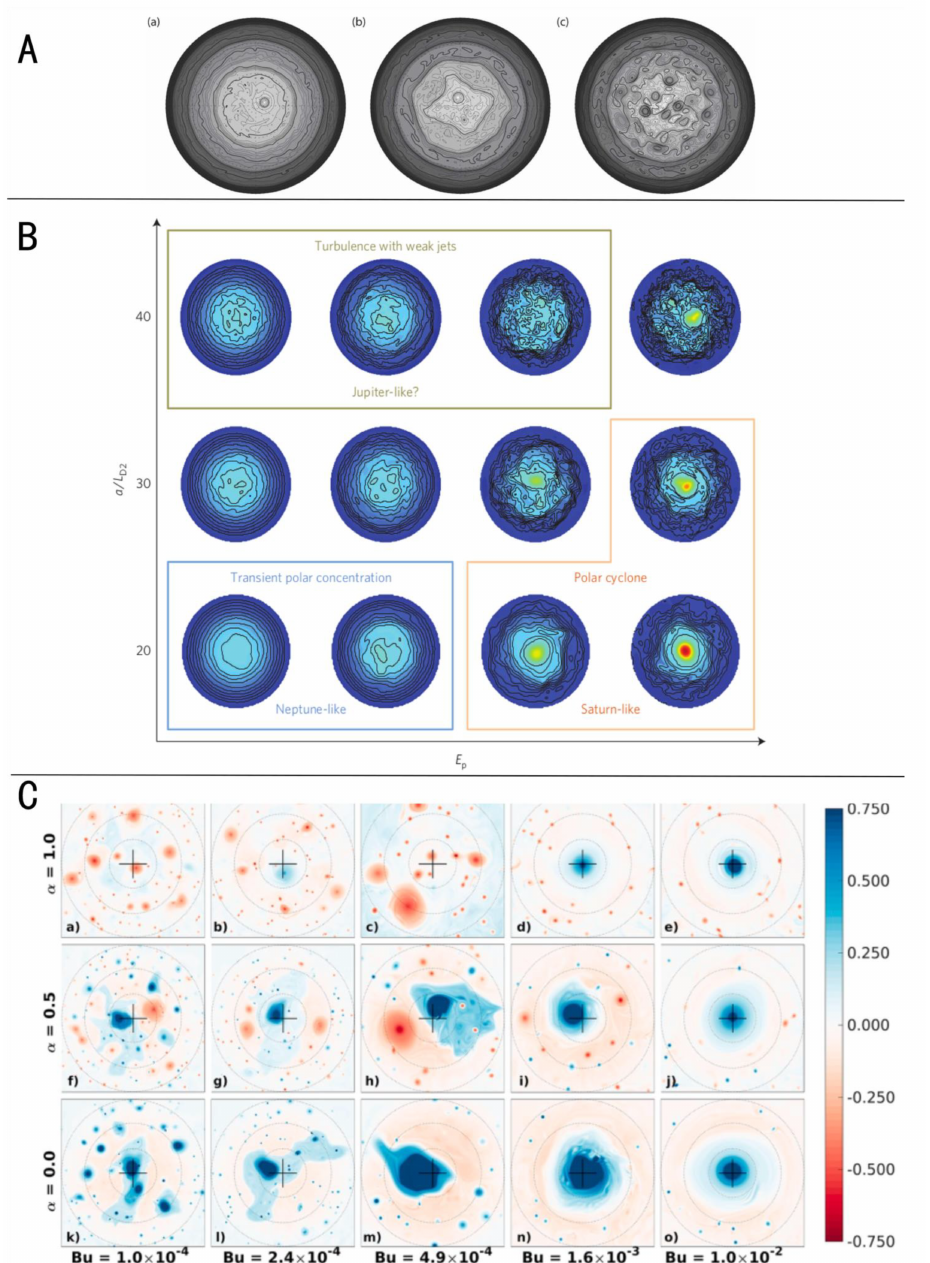
Figure 14. Polar Projections from Shallow Water Models. ( A ) PV as a Function of L D from Large (Left) to Small Right. ( B ) a / L D vs. Storm Energy showing different regimes. ( C ) Storm Polarity Fraction vs. Bu Number showing Dynamical Regimes ( a – o ). ( a ). Reproduced from [189], ( b ). Reproduced from [220], ( c ). Reproduced from